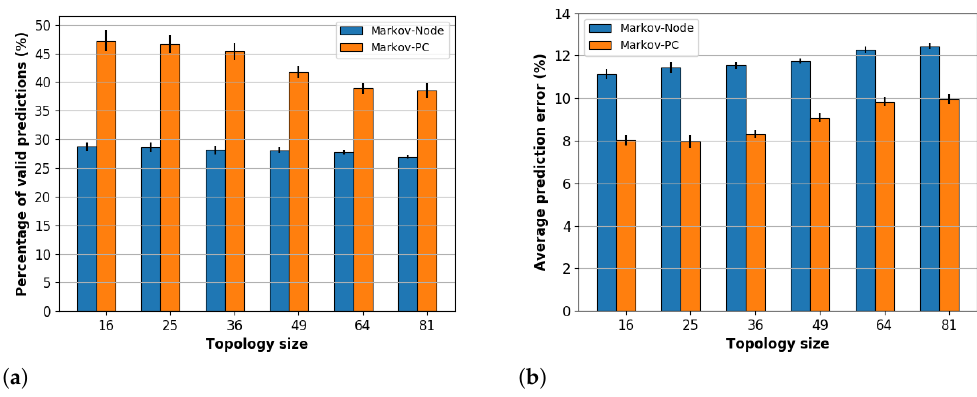
Figure 4. Markov chain prediction accuracy: ( a ) shows the percentage of valid predictions ( < 5%) for the case running on the sensor node and running on the SDN controller and ( b ) shows the average prediction error for these two cases as